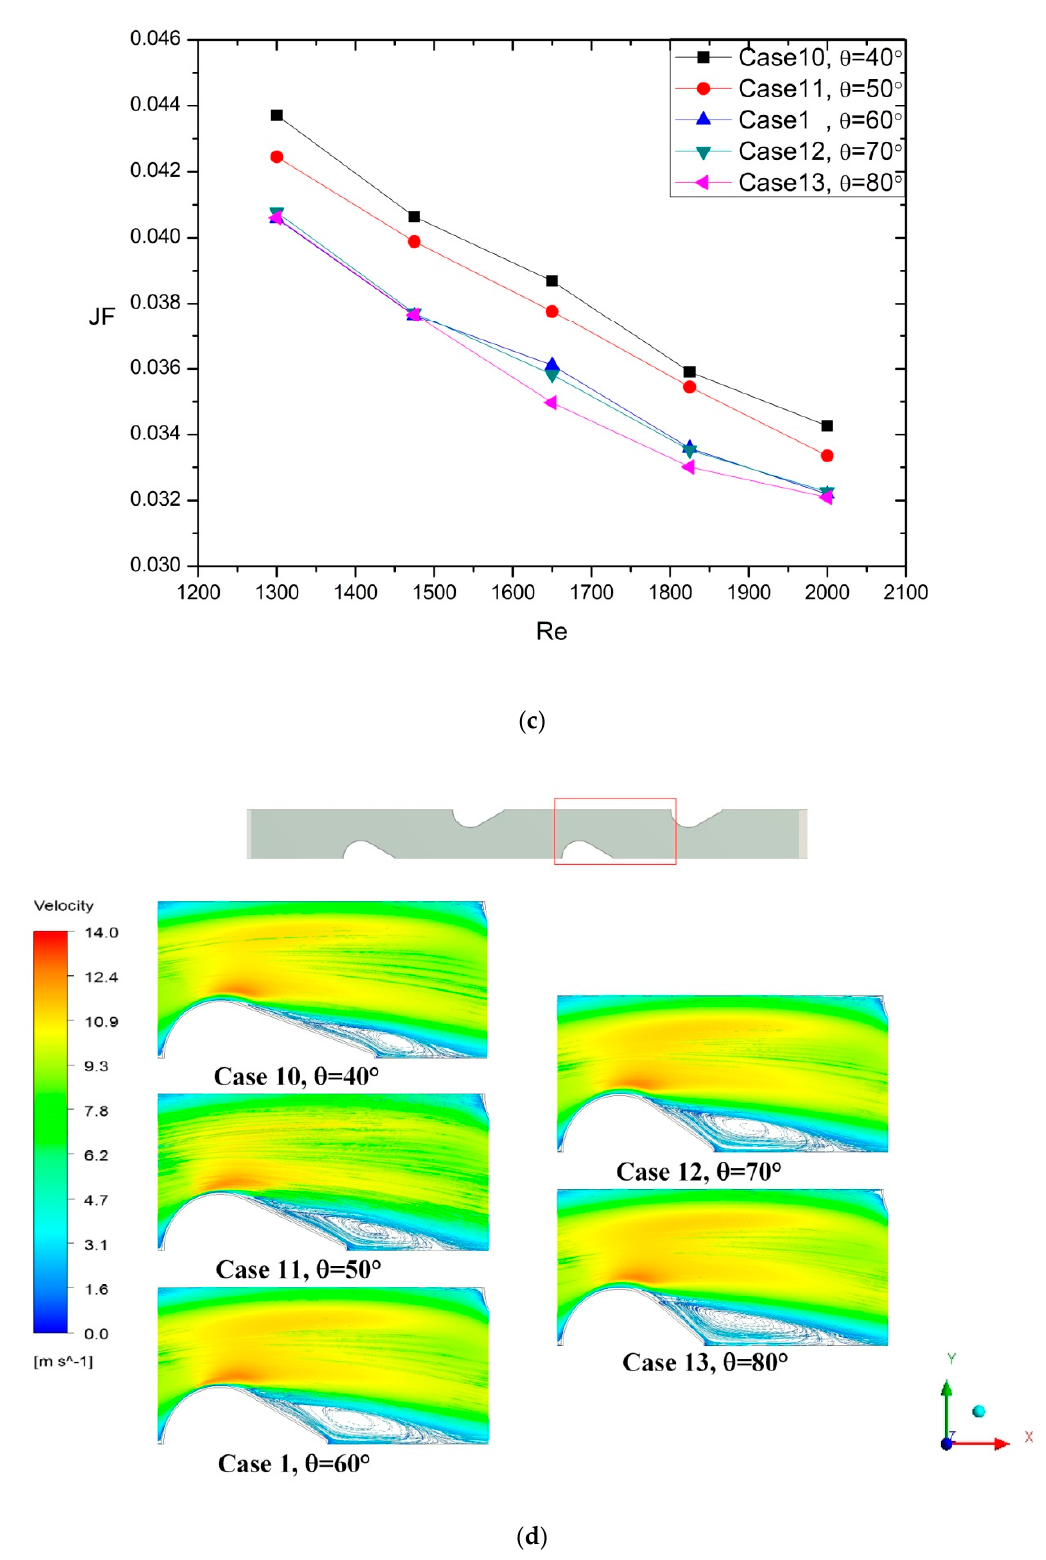
Figure 7. ( a ) j factor of different angle on Reynolds number, (b) f factor of different angle on Reynolds number, ( c ) JF factor of different angle on Reynolds number, ( d ) The flow field of different angles as the radius keep constant .